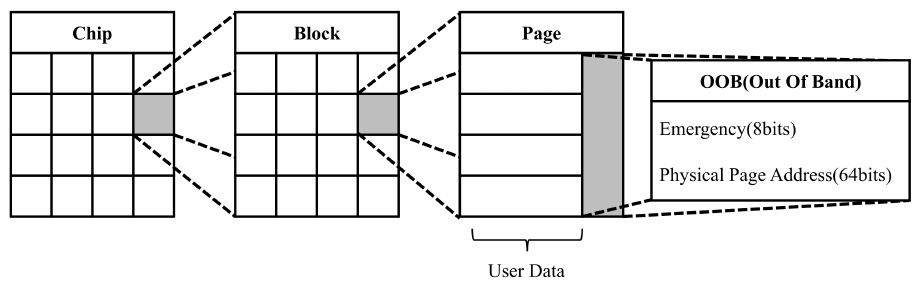
Figure 9. OOB area in NAND flash